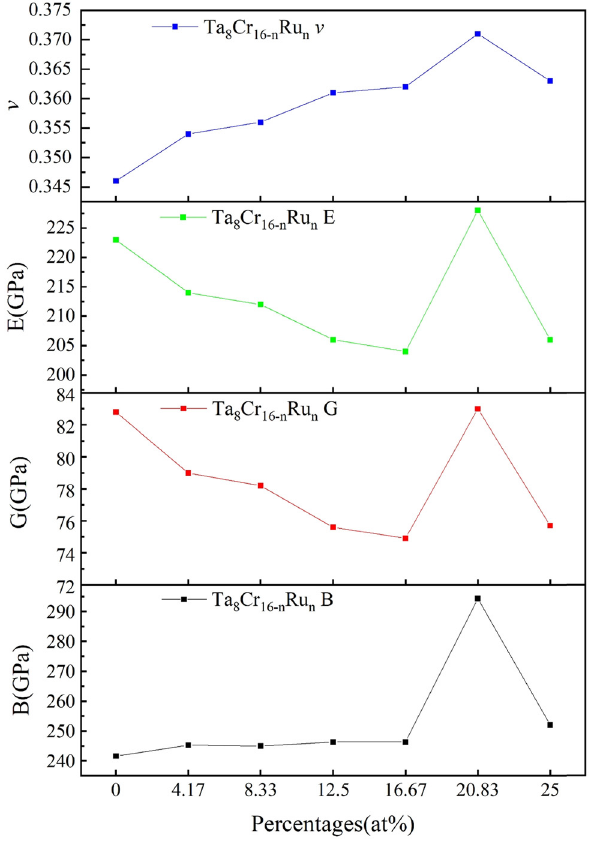
Figure 5: Elastic constants of ternary phases with di ff erent percen - tage concentrations of ruthenium